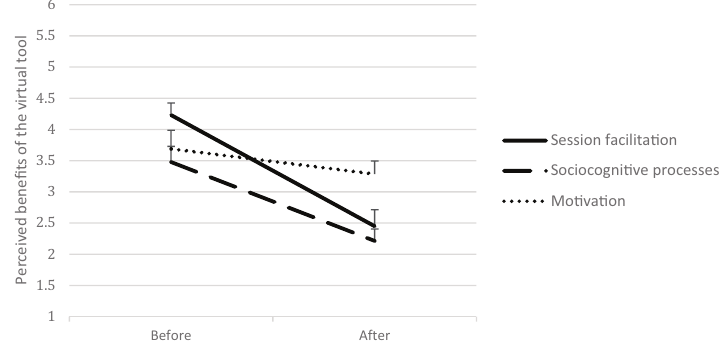
Figure 2. Benefits of the virtual environment on session facilitation, creative processes and motivation, as rated by experts before and after the test (source: created by authors)